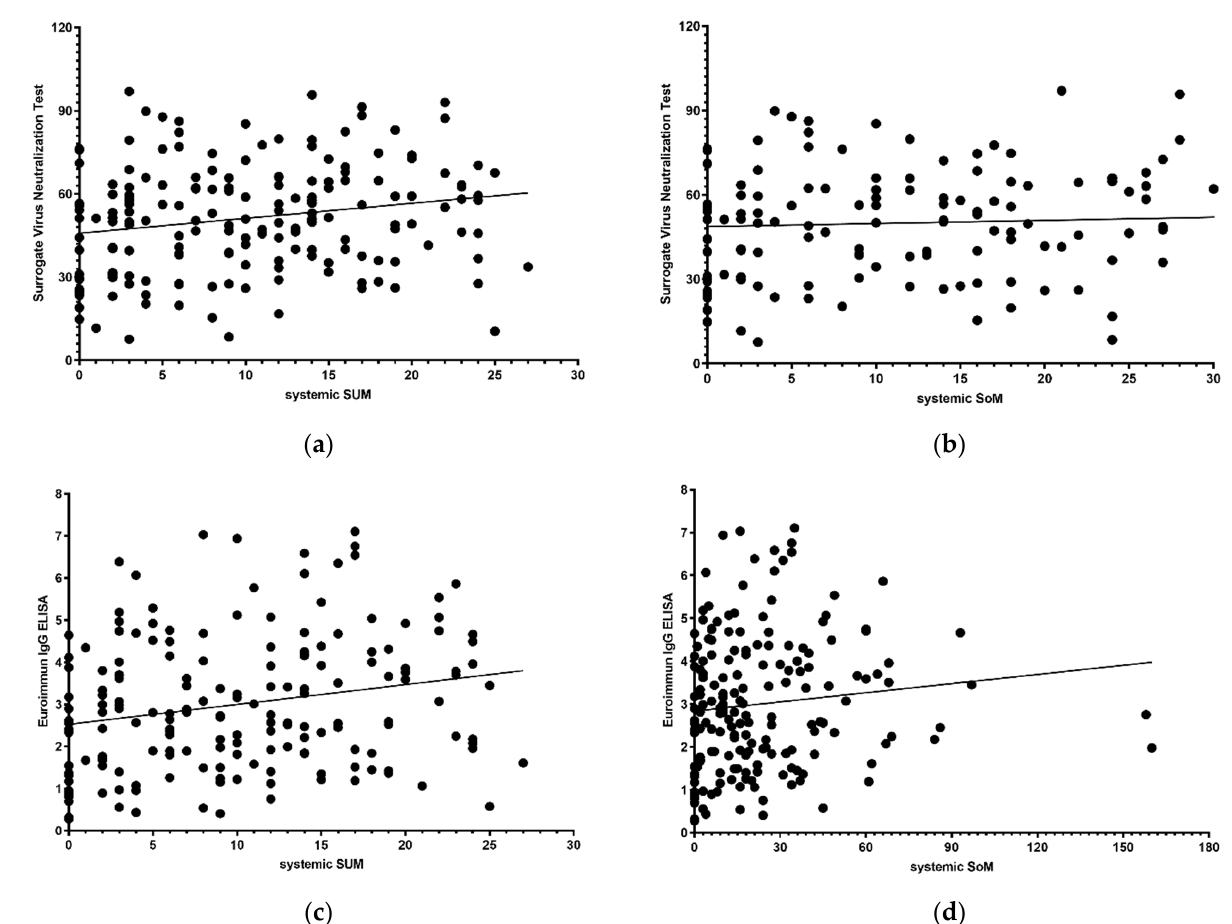
Figure 1. Antibody response by scores of systemic adverse events. ( a ) Values of surrogate virus neutralization test by systemic SUM; ( b ) values of surrogate virus neutralization test by systemic SoM; ( c ) values of Euroimmun IgG ELISA by systemic SUM; ( d ) values of Euroimmun IgG ELISA by systemic SoM. Abbreviations: ELISA, enzyme-linked immunosorbent assay; SUM, sum of symptoms’ severity score; SoM, sum of multiplying each symptoms’ severity by the duration of symptoms.